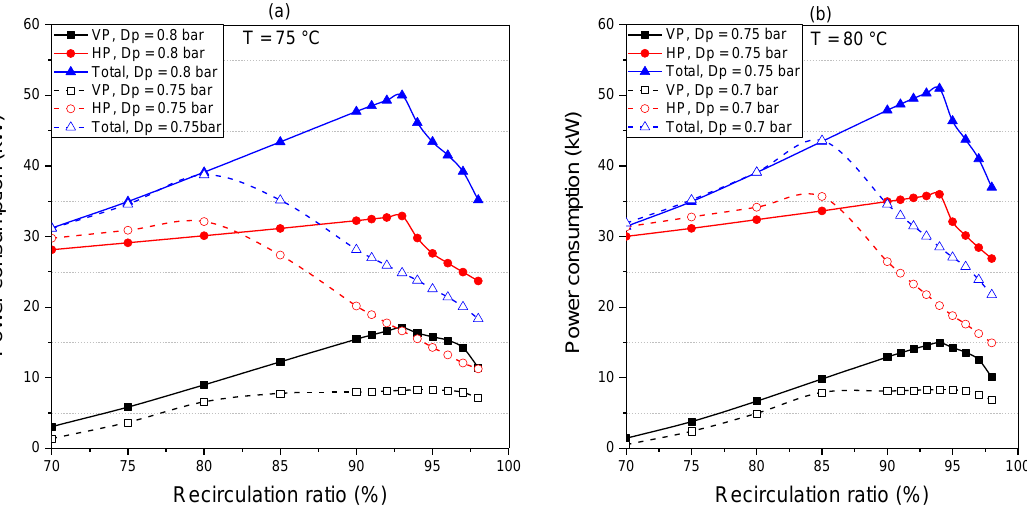
Figure 12. Power consumption of the vacuum pump, heat pump and the whole system for Δp = 0.75 and 0.8 bar at 75 °C ( a ) and for Δp = 0.7 and 0.75 bar at 80 °C ( b ).